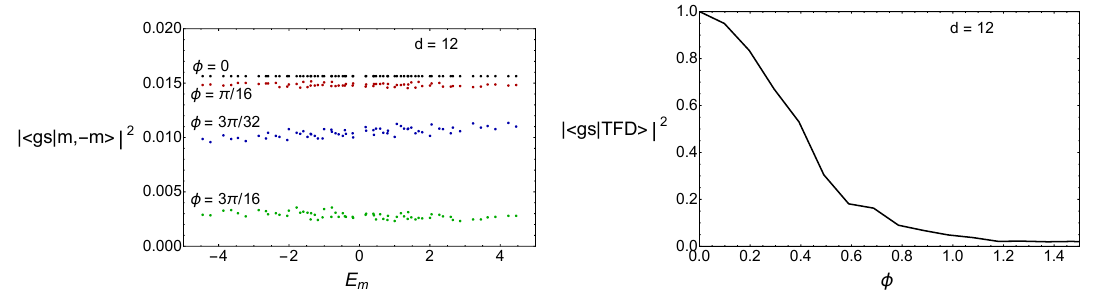
Figure 9 . The overlap of the ground state of the HC model with the components of the TFD state (left) for several values of the magnetic flux. In the right figure we show the total overlap between the ground state of the HC model and the TFD state. Because the zero energy states (7.15) are degenerate we have a small symmetry breaking term to this Hamiltonian by iγ L For the figures above we used (cid:15) = 10 − 4